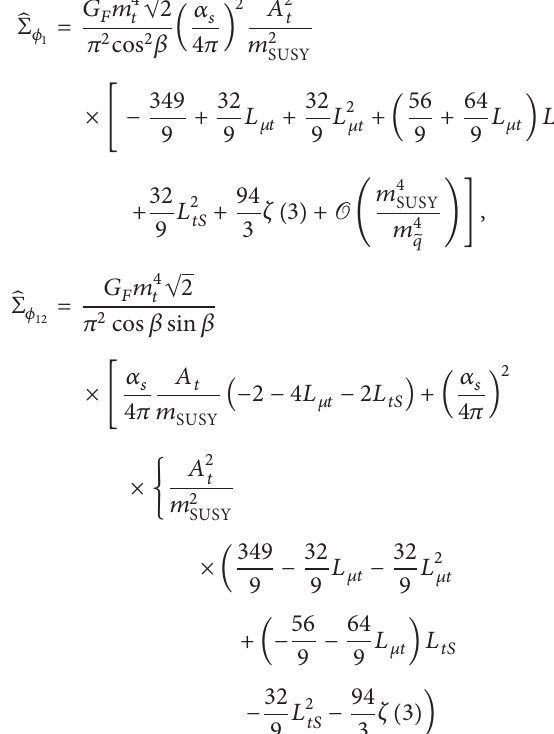
Figure16:Renormalizationschemedependenceof 𝑀 ℎ asafunction of 𝑚 1/2 adopting SPS2. Dotted, dashed, and solid curves correspond to one-, two-, and three-loop results. The DR (on-shell) results correspond to the lower (upper) curves. The three-loop curves obtained in the two renormalization schemes lay on top of each